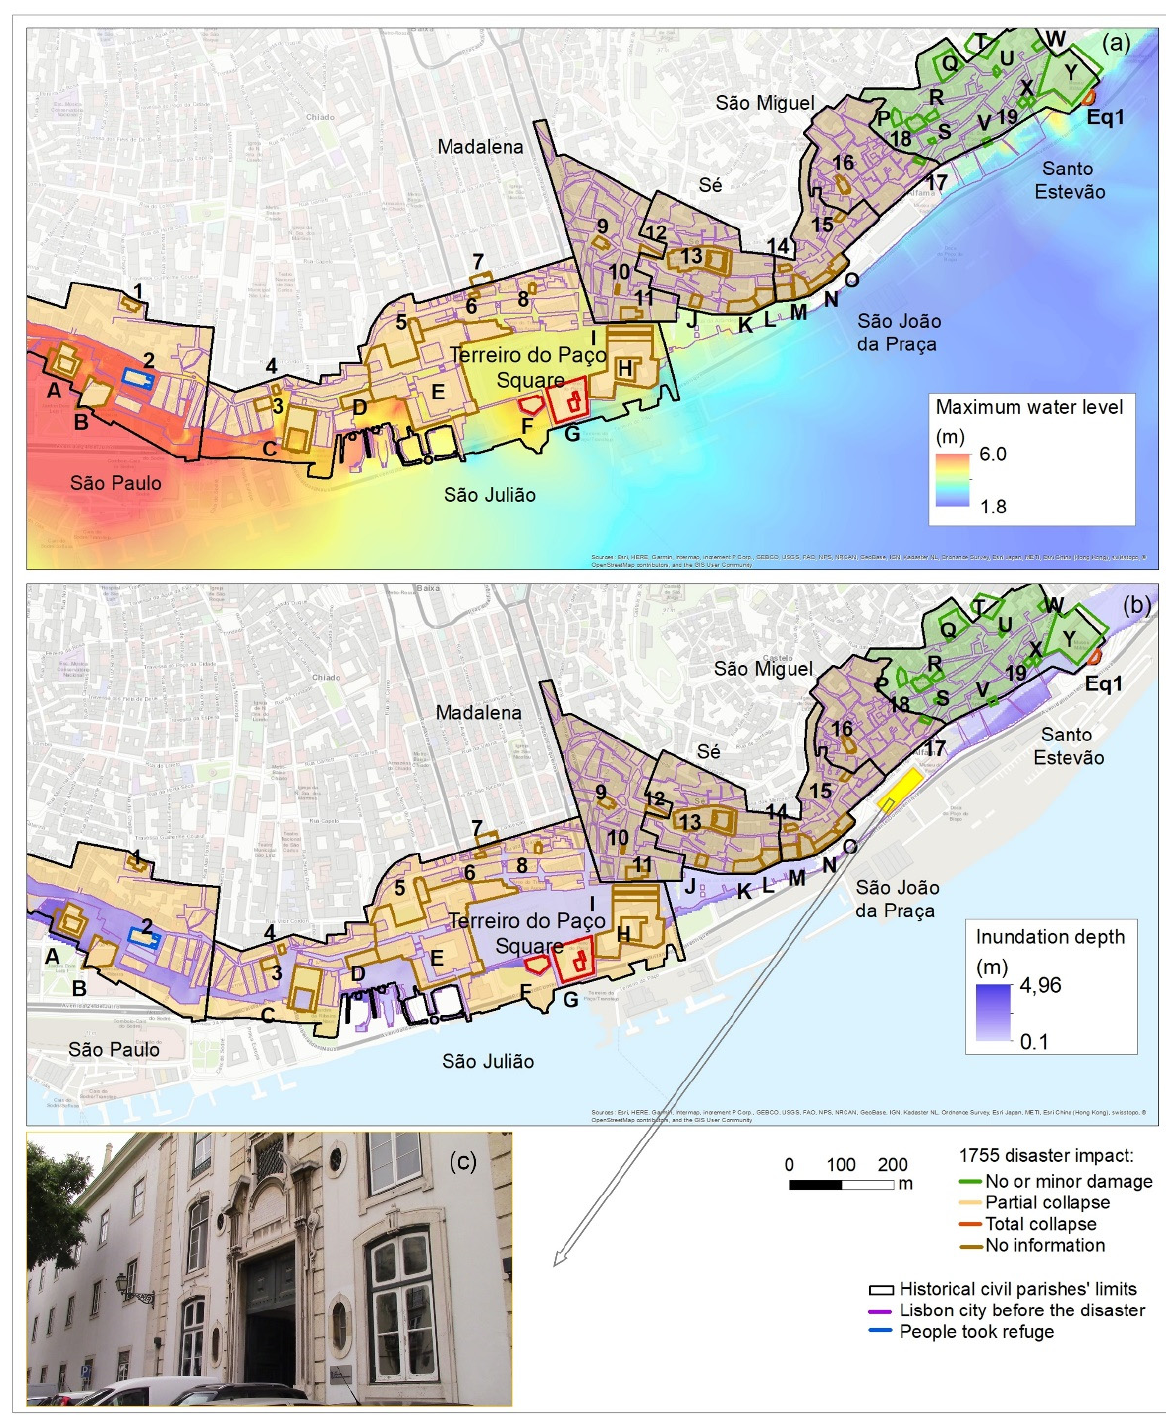
Figure 10. ( a ) Tsunami numerical results of the maximum water level; ( b ) tsunami numerical results of the inundation depth; ( c ) photo of the present-day Costumes building; the facade is viewed from the present day Jardim do Tabaco Street. List of buildings in civil parishes of São Paulo, São Julião,